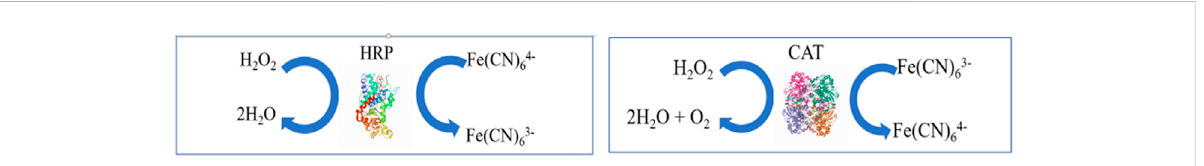
FIGURE 1 Redox reactions and associated mediators for the electrochemical detection of catalase (A) (left) Oxidation of hexacyanoferrate (II) by HRP, (B) (right) reduction of hexacyanoferrate (III) by H 2 O 2 . Molecular structure of the enzymes obtained from the protein database (Berglund et al., 2022; Sugadev et al.,